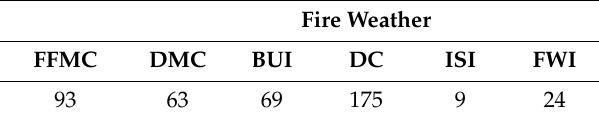
Table 2. Pelican Mountain Temporary Automatic Fire Weather Indexes from May 31. The